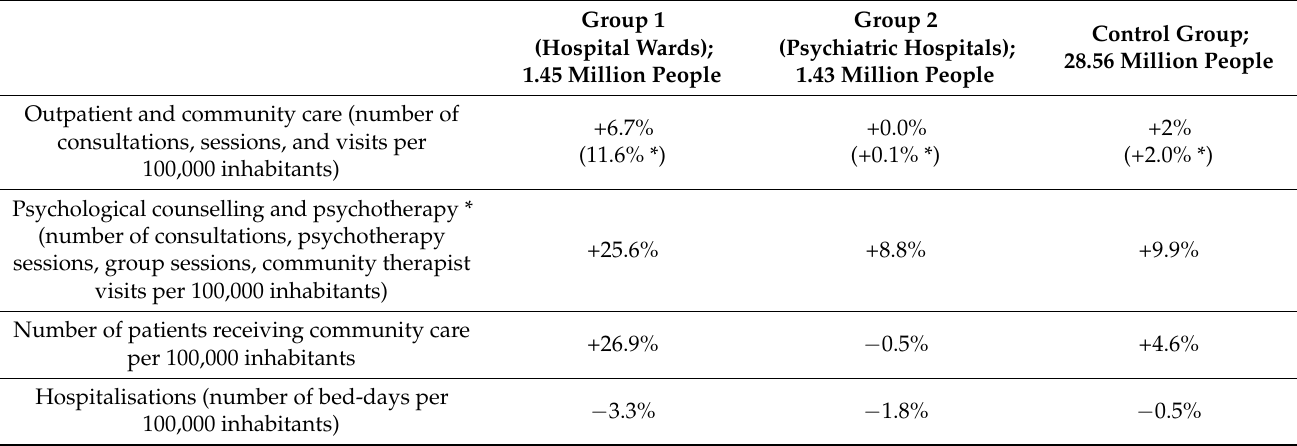
Table 1. Changes in access to mental health services within and outside of the pilot, % age change between 2018 and